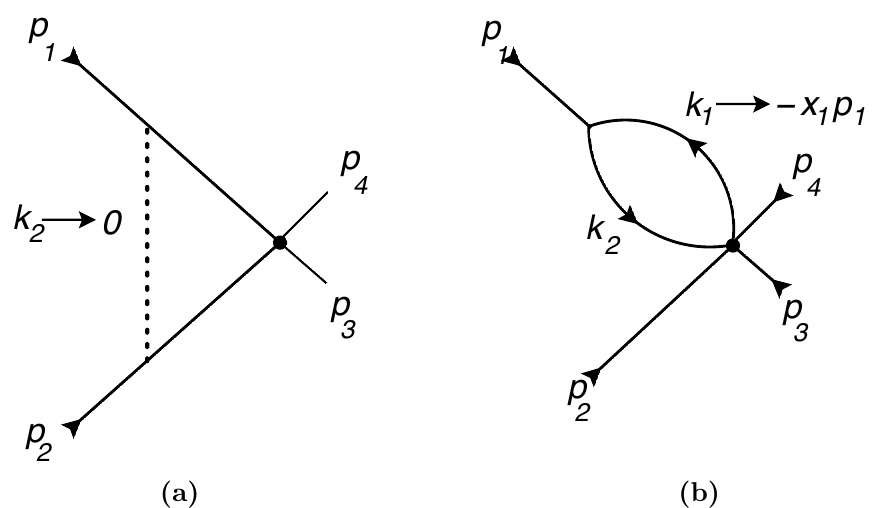
Figure 3 . Reduced diagrams for representative pinch surfaces of the one-loop box: (a) soft limit k 2 0, (b) Collinear surface k 1 !